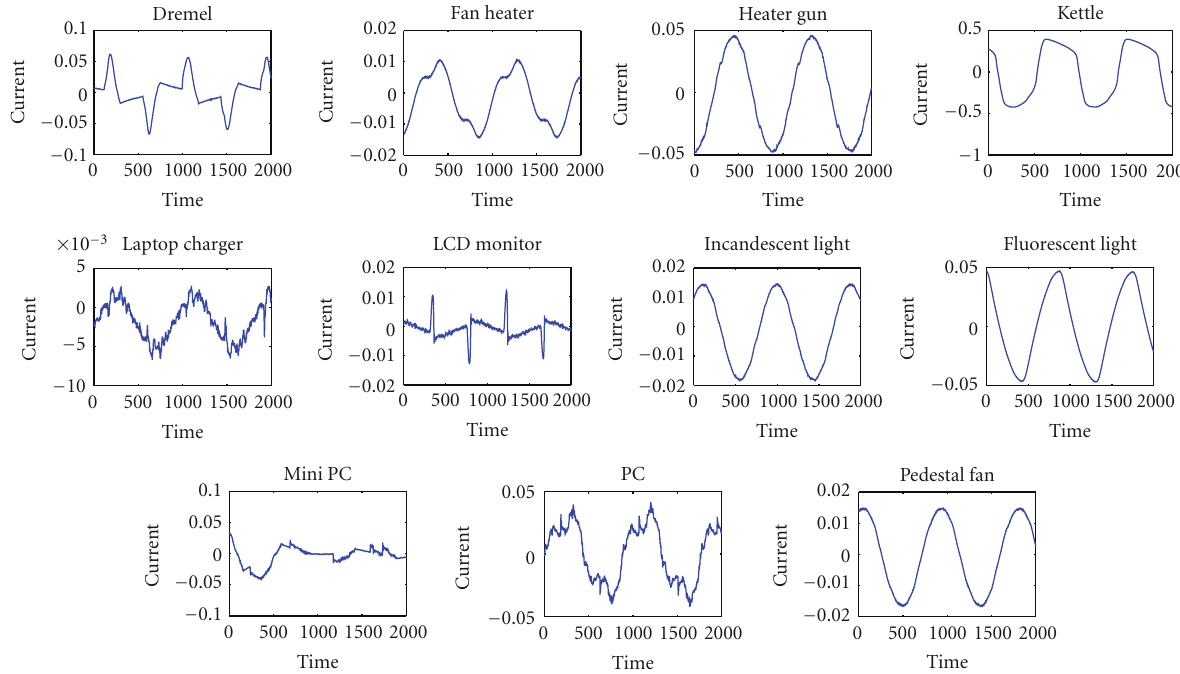
Figure 6: Examples of training set of unprocessed current data in time domain (steady state).